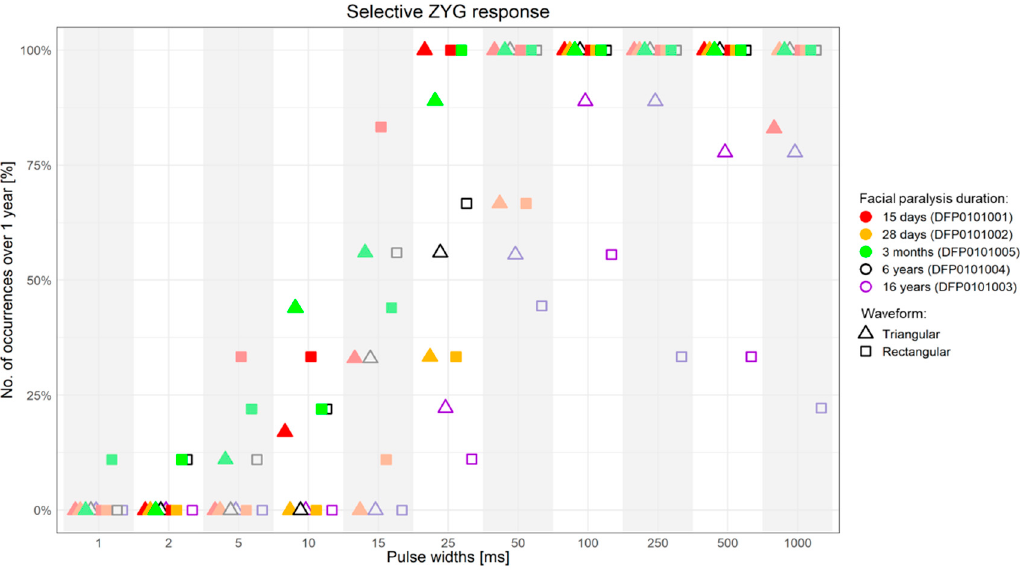
Figure 3. Percentage of successful selective ZYG response ( y -axis) when the stimulation was presented with specific PWs ( x -axis) over 1-year follow-up. ms = milliseconds.